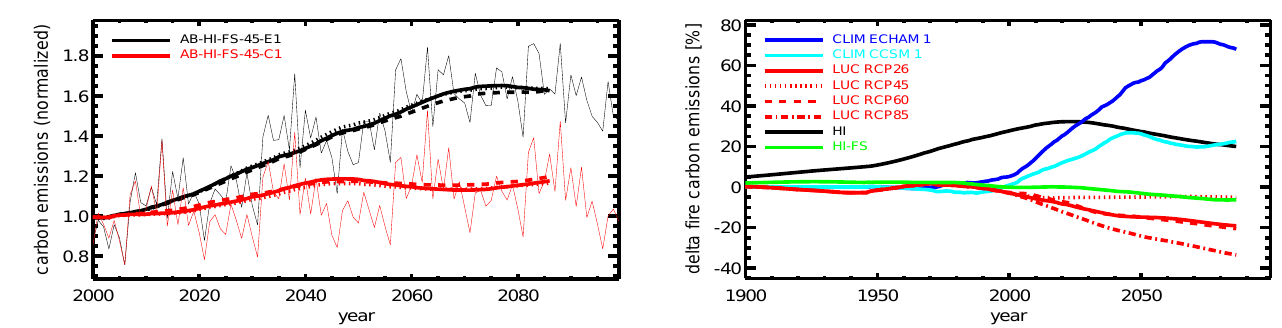
Fig. 2. Change in future global annual mean fire emissions normal- ized to the mean state 1990–2009 as simuated with two different climate forcings (ECHAM/MPI-OM (E1; Roeckner et al., 2006) or CCSM (C1; Meehl et al., 2006)) when human ignition (HI) and fire suppresion (FS) were taken into account and future LUC/Harvest followed RCP 45. For each experiment three ensemble simulations are shown (see also Table 1 for a description of the experiments). The timeseries were smoothed with a 25yr running mean. In addi- tion, for each experiment one ensemble is shown with a yearly time resolution (thin solid line).